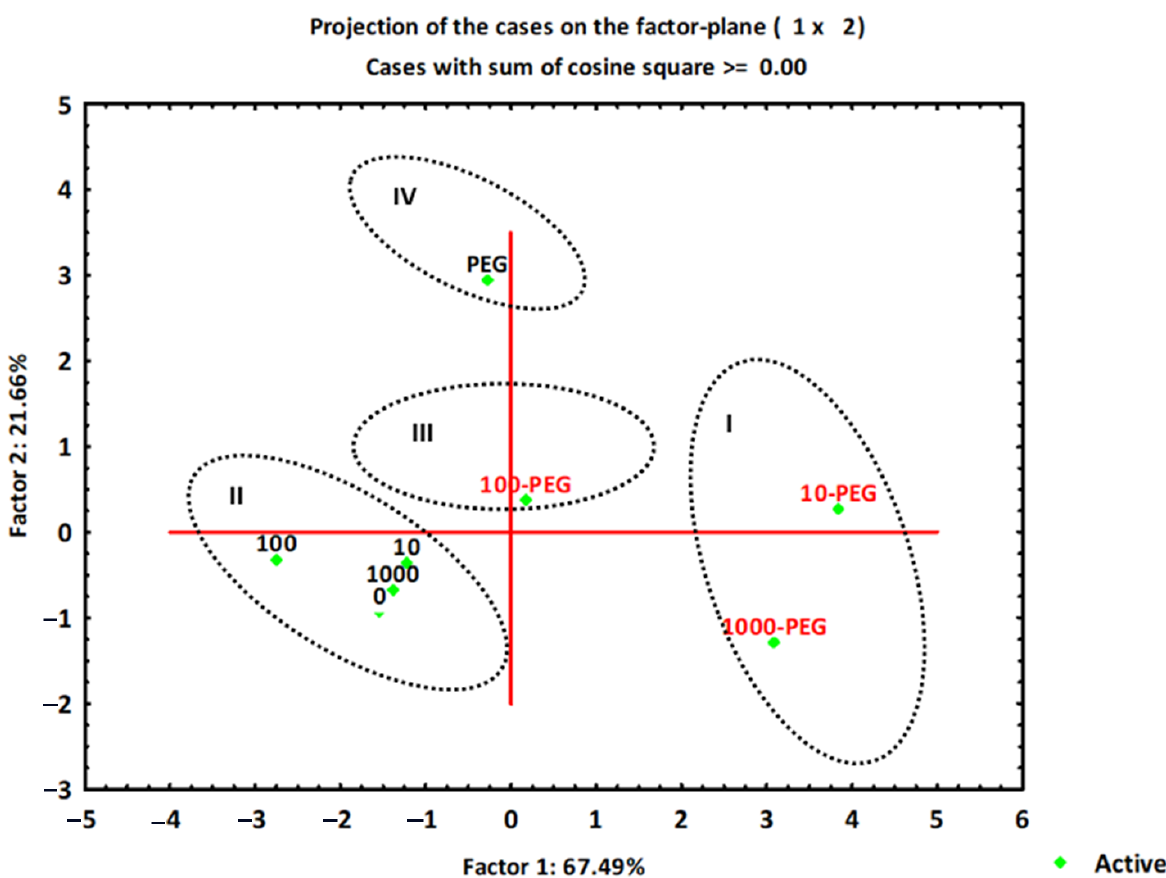
Figure 4. Principal component analysis (PCA) of data sets of morphometric parameters under drought (PEG), fullerol C 60 (OH) 24 nanoparticles (FNP; 10, 100, and 1000 ng mL − 1 ) and combined FNP–PEG treatments (10 ng mL − 1 FNP + PEG, 100 ng mL − 1 FNP + PEG, and 1000 ng mL − 1 FNP + PEG). Scores of the first two factors. Black letters present control; red letters present drought. PCA was used to distinguish the effect of single treatment application (control, drought or nanoparticles) and combined drought-nanoparticle treatment. Values are means ± S.D. ( n = 3). The different letters indicate statistically significant differences among the mean values of different treatments at p < 0.05 using Tukey’s post-hoc test. ▪ Active data.